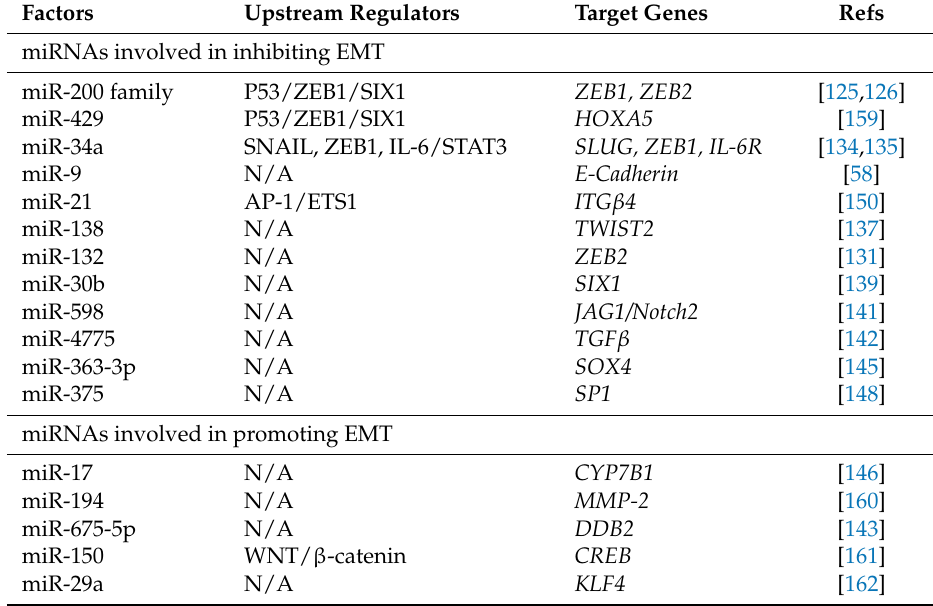
Table 2. Micro-RNAs (miRNAs) involved in EMT in colorectal